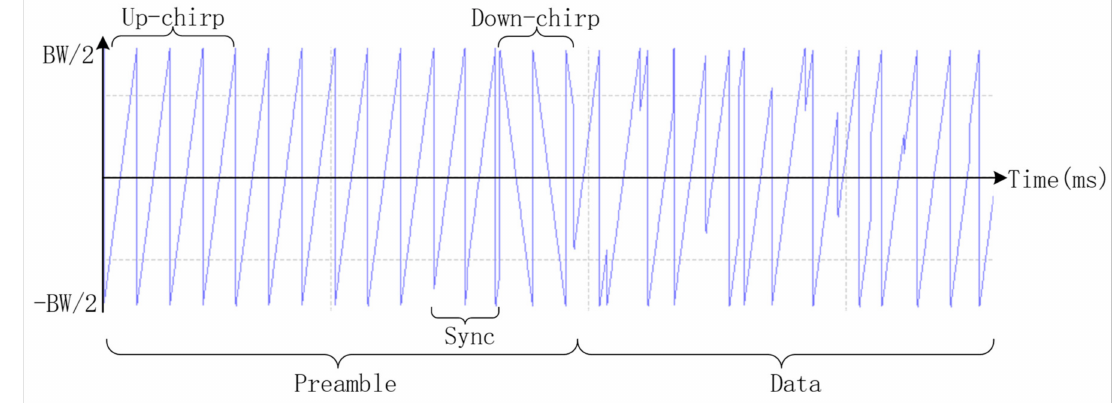
Figure 1. The LoRa packet